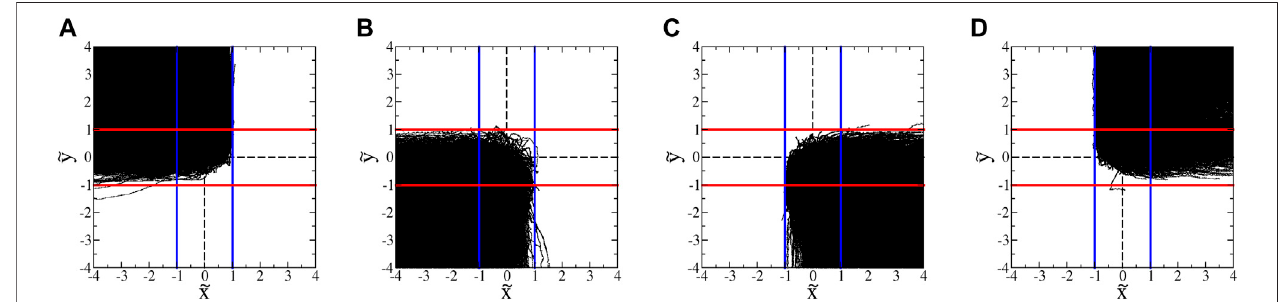
FIGURE13| :Trajectoriesoftetraselmisinhyperbolic fl owwith A =1.8s − 1 .(Thesedataexcludetrajectorieswithclassicrun-and-tumbleeventsduringatrajectory.) Theblueandredlinesshowtheinward-andoutward-blockingSwIMedges,respectively. (A) Alltrajectoriesthatenterfromthetopandleavetotheleft. (B) Alltrajectories thatenter fromthebottom andleave totheleft. (C) Alltrajectories thatenterfromthebottom andleavetotheright. (D) Alltrajectoriesthatenterfrom thetopand leaveto the right.